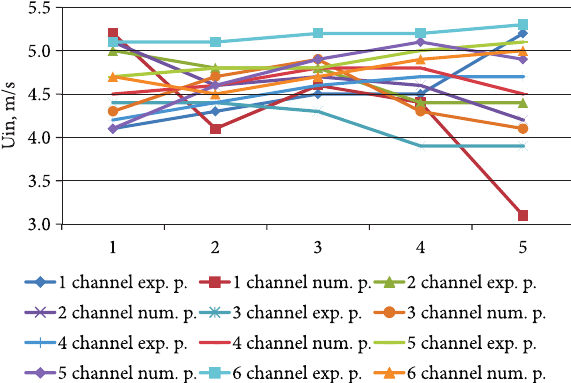
Fig. 7. Experimental studies and numerical simulations to obtain the gas flow tangential velocities in six channels of multi-channel spiral cyclone separator (5